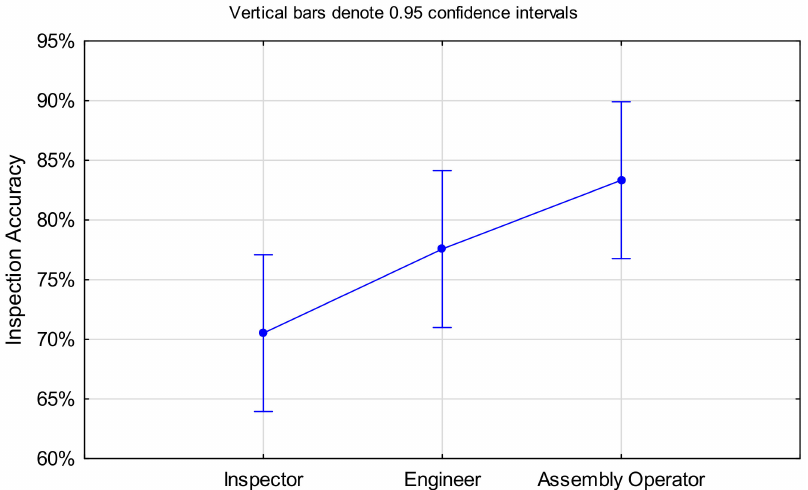
Figure 10. Mean plot of inspection accuracy by